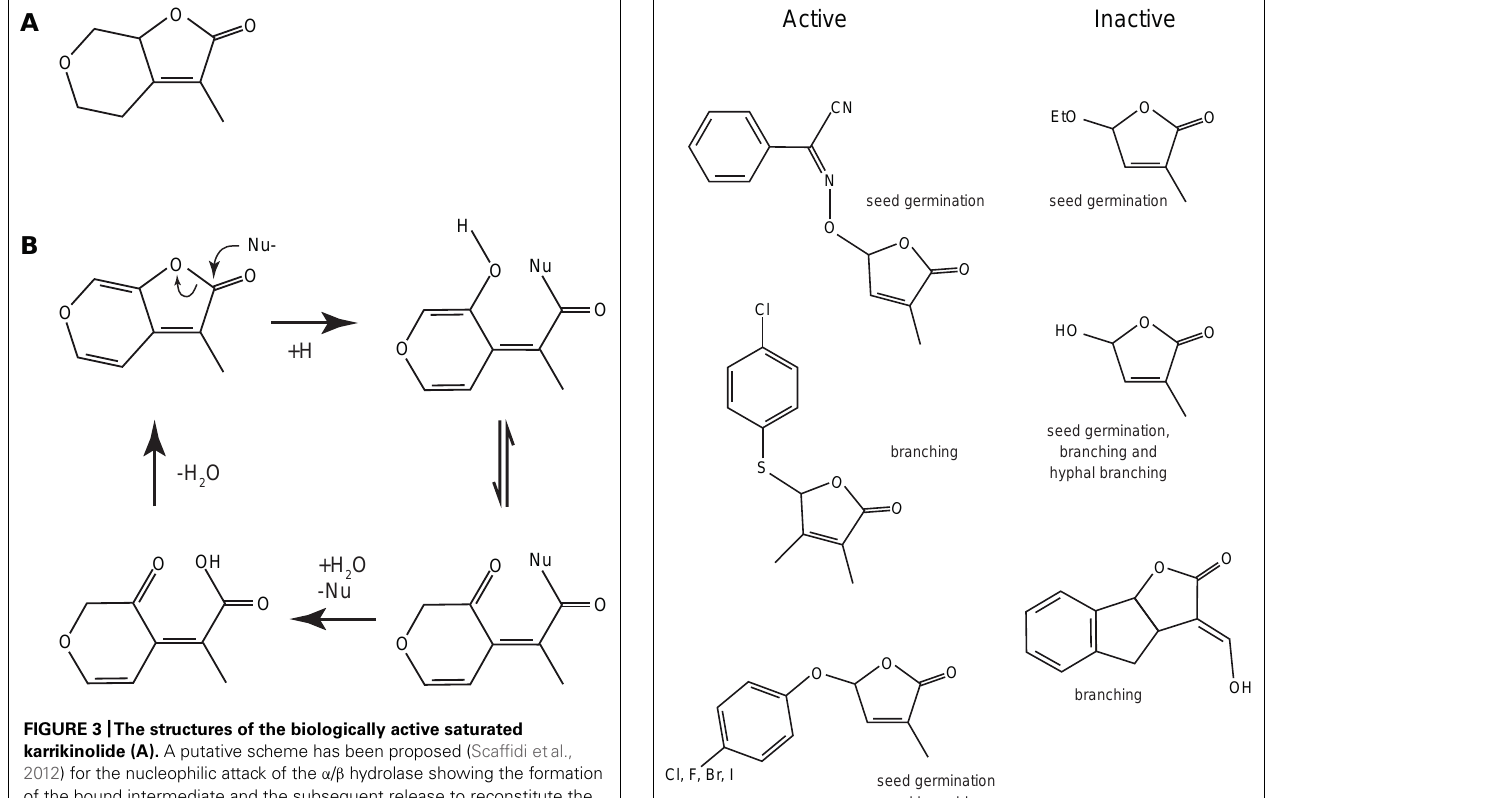
cavity ( Figure 2 ; Hamiaux et al., 2012). In the case of the non- catalytic receptor GID1, interactions between GA and the “active site serine and aspartic acid” appear to result in movement of the 2008). Subsequent interactions with both the DELLA